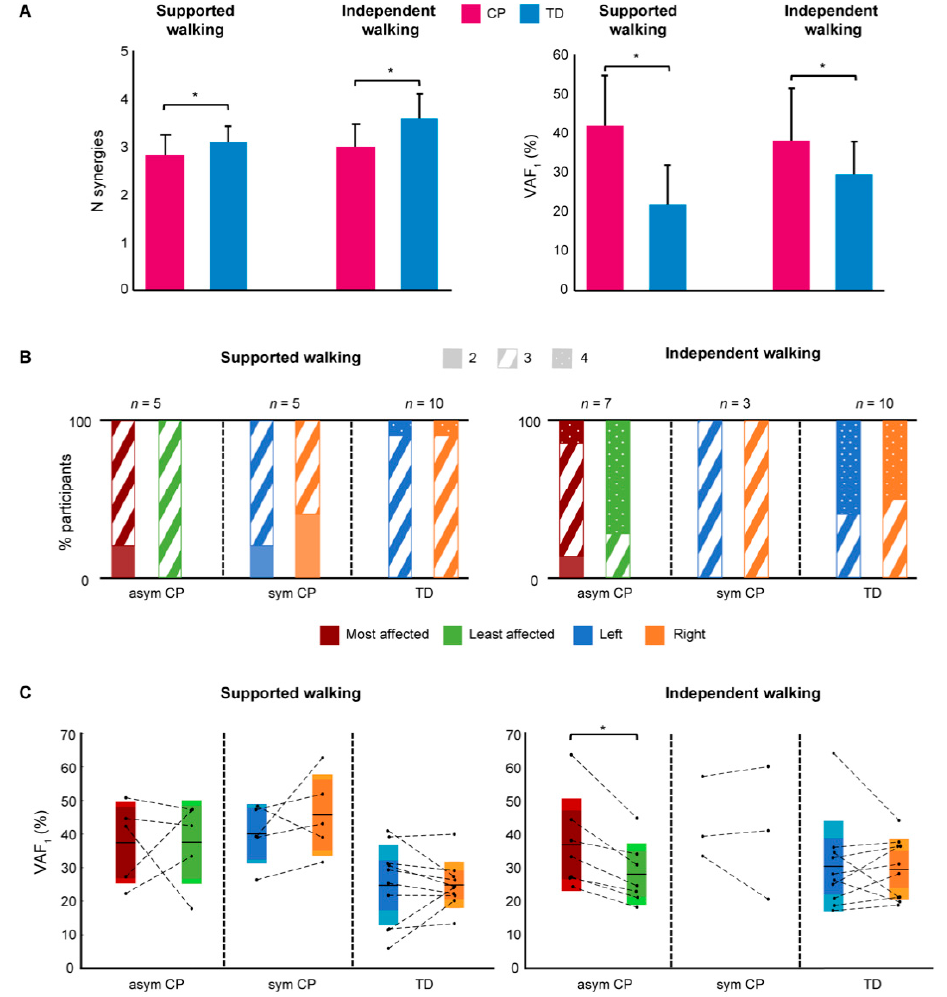
Figure 3. Unilateral EMG analysis results. ( A ) Mean number (N) of synergies ( left ) and variability accounted for ( right ) by one synergy (VAF1) for the CP and TD group, for supported walking and independent walking. Error bars indicate SDs. The unilateral EMG analysis involves the most affected side for the asymmetric CP group and a random side for the symmetric CP and TD group. ( B ) Percentage number of synergies for each side. The most affected (red) and least affected (green) side for asymmetric CP, and the left (blue) and right (orange) side for symmetric CP and TD. ( C ) Variability accounted for by one synergy (VAF 1 ) for each side. Mean VAF 1 per side is indicated by the black line in the middle of the box. The dark color of the box indicates the 95% confidence interval, and the lighter color one standard deviation. Individual participant values are indicated by black dots, and both sides of each participant are connected by broken lines. Significance between sides is indicated by a *, p < 0.05. Abbreviations: asym = asymmetric; sym = symmetric; n = number of participants.